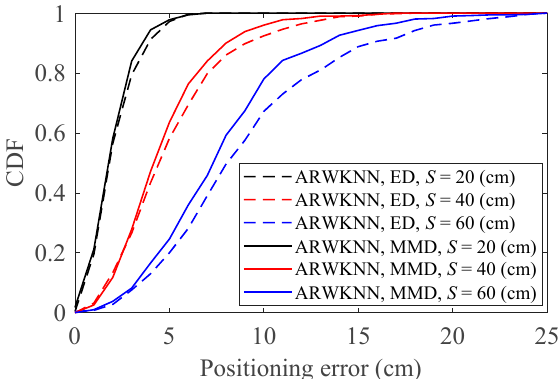
Figure 21. In 3-D, the cumulative distributions of positioning errors for the ED and CLD metrics with various S values. K max = 8.